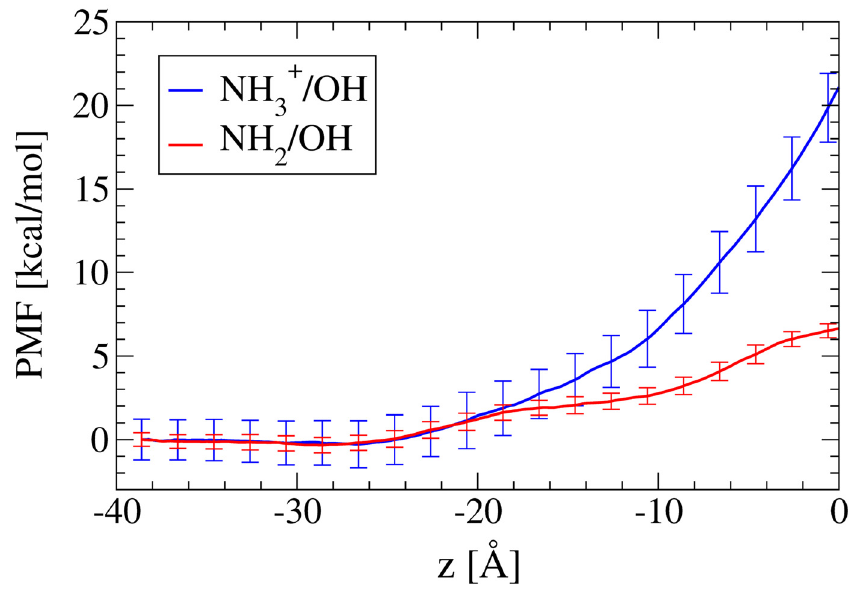
Fig 6. The PMF of tyr and tyr + shown together for comparison. Error bars are to two standard errors. Here z = − 40 Å is the bulk solution andf z = 0 is the bilayer